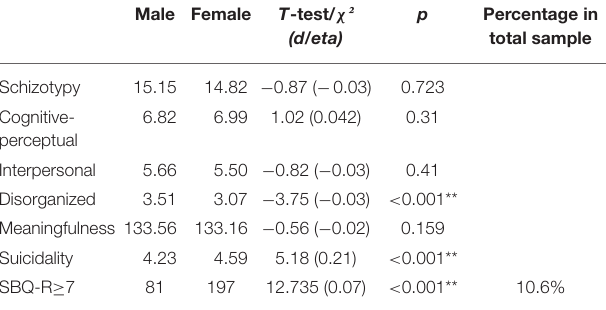
TABLE 3 | Different performance in males and